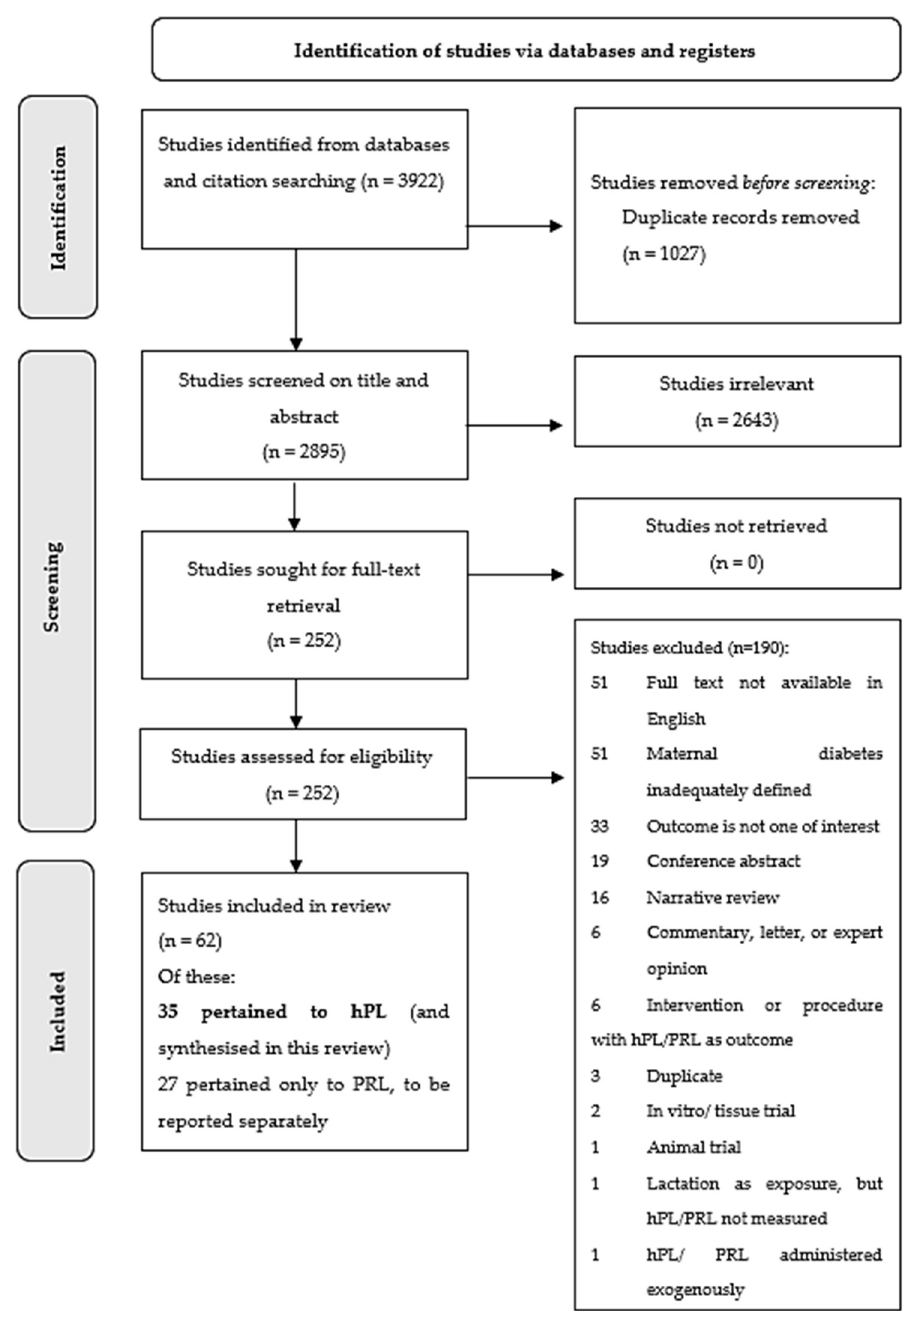
Figure 1. PRISMA flowchart.